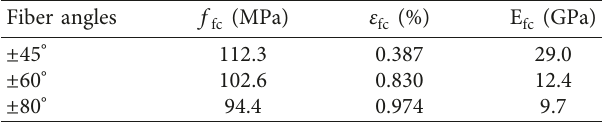
Figure 8: Axial stress-axial strain curves of FRP short tubes. Table 3: Properties of short FRP tubes under axial compression. Table 4: Properties of steel